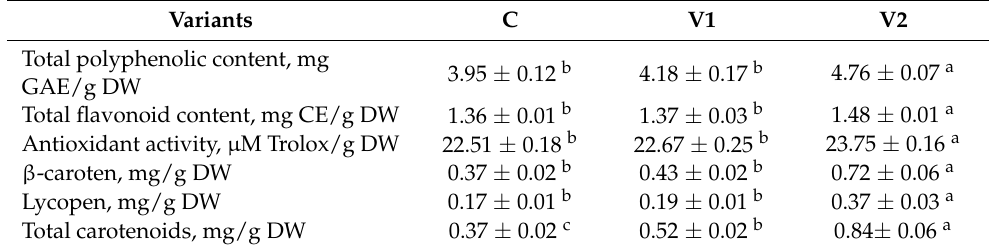
Table 4. Phytochemicalprofileandantioxidantactivityofproteinbarswithfreeze-driedpowders addition.